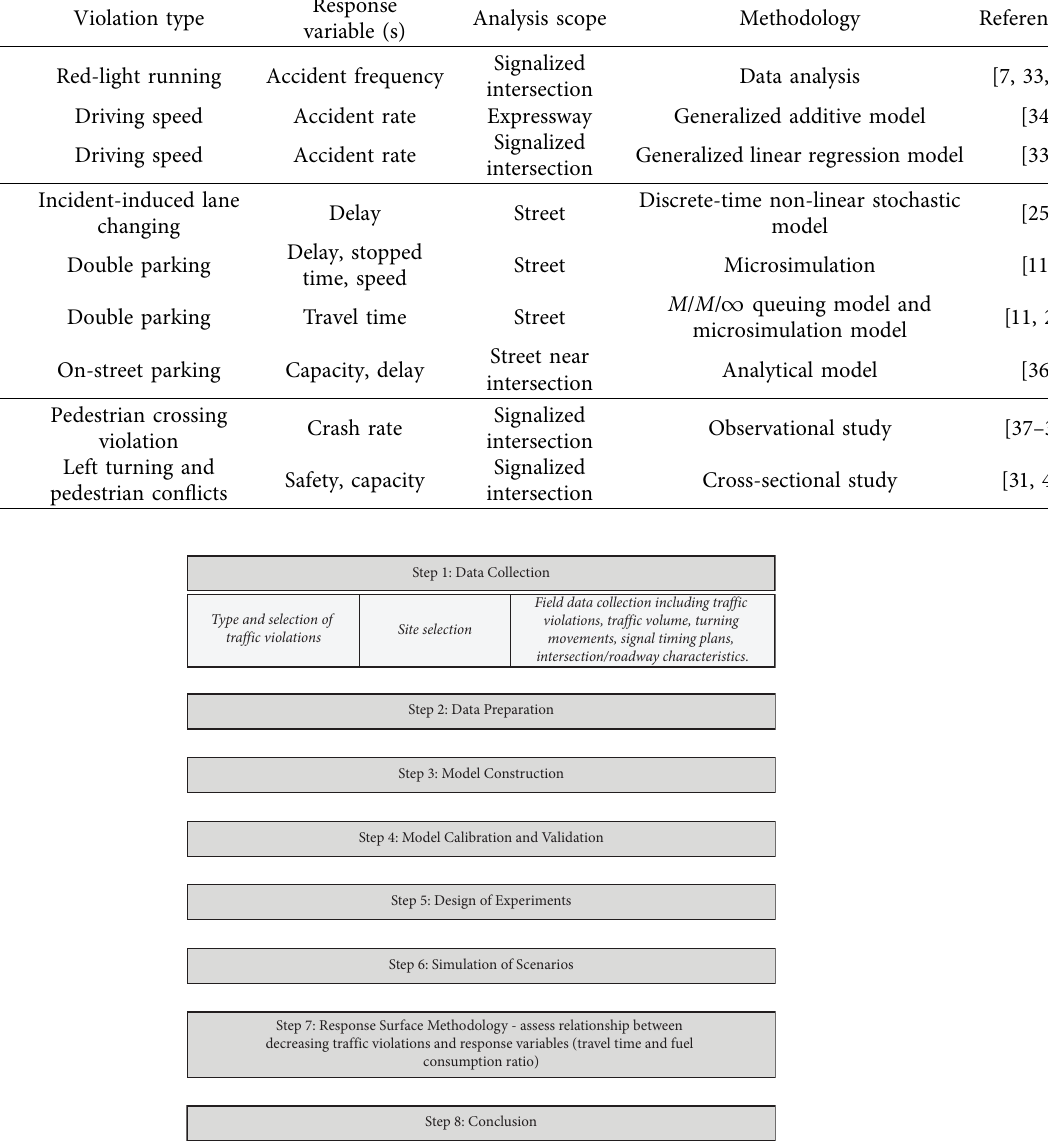
Figure 1: Research